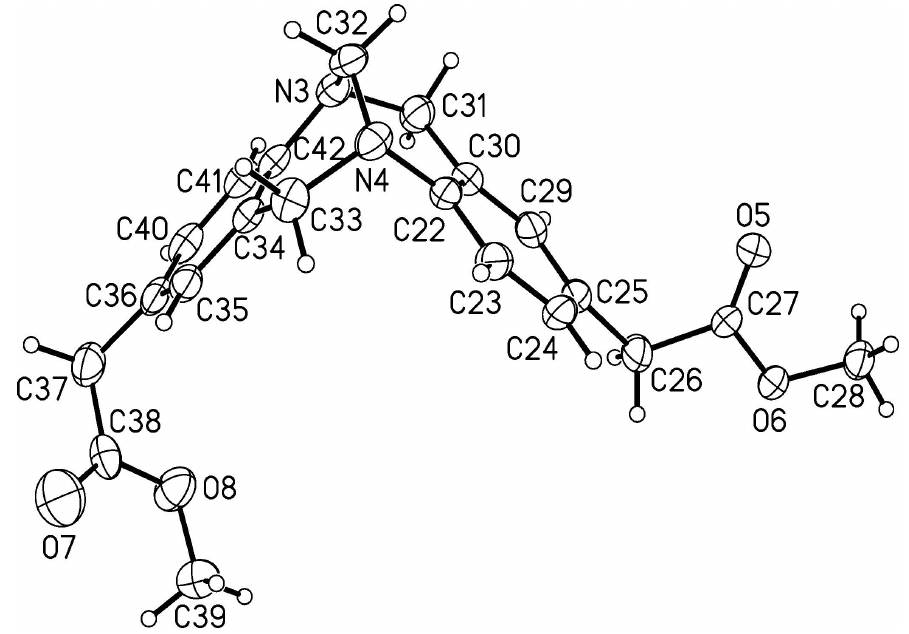
Figure 2 View of the second of the two unique molecules present in the asymmetric unit of (I), with the atom-numbering scheme. Displacement ellipsoids are drawn at the 50% probability